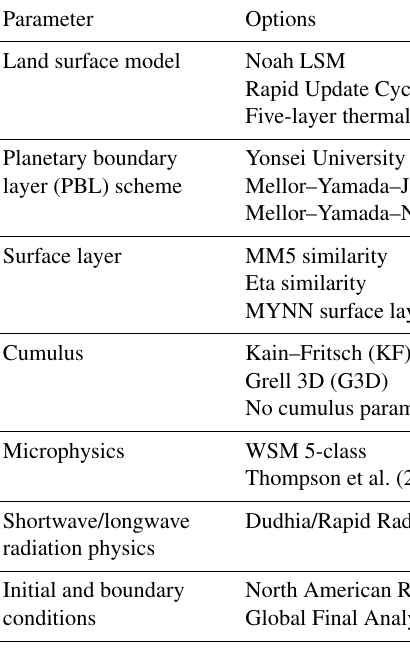
Table 1. Physics schemes used in WRF for the sensitivity